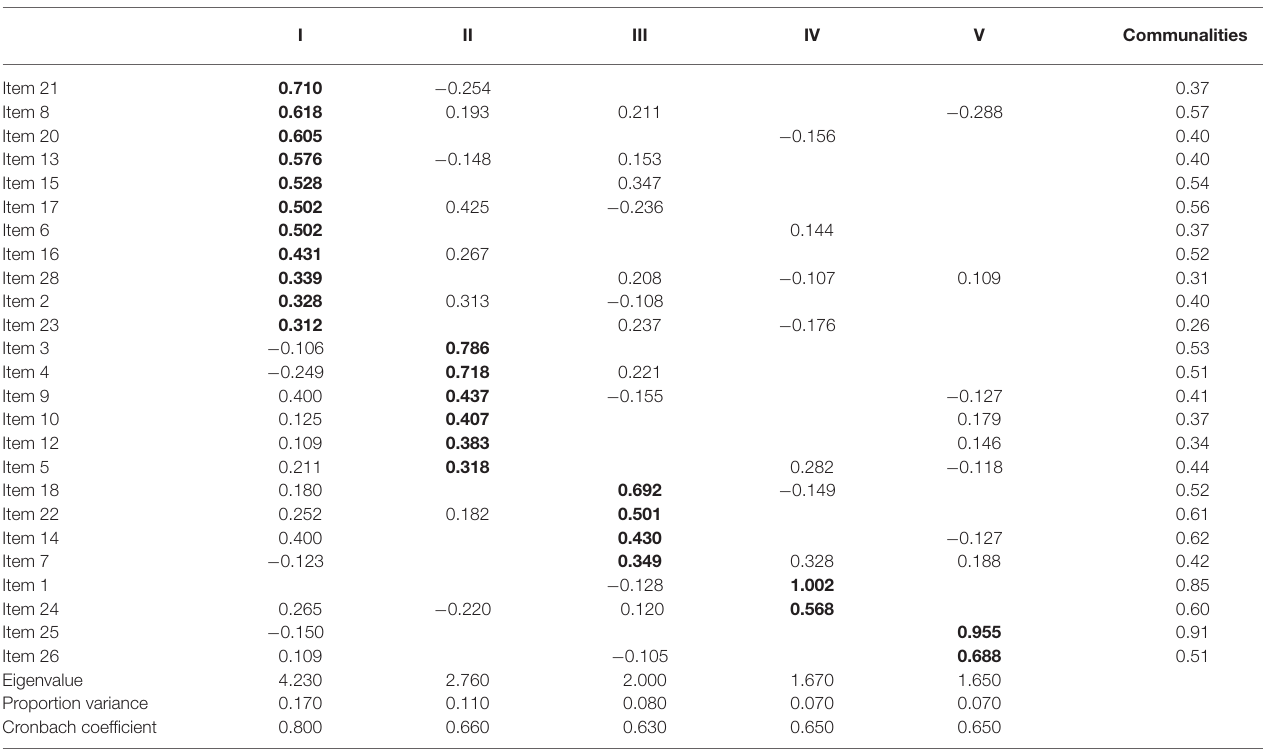
TABLE 3 | Exploratory factor analysis (EFA) of the EMQ with component loadings of each item. I II III IV V Communalities Item